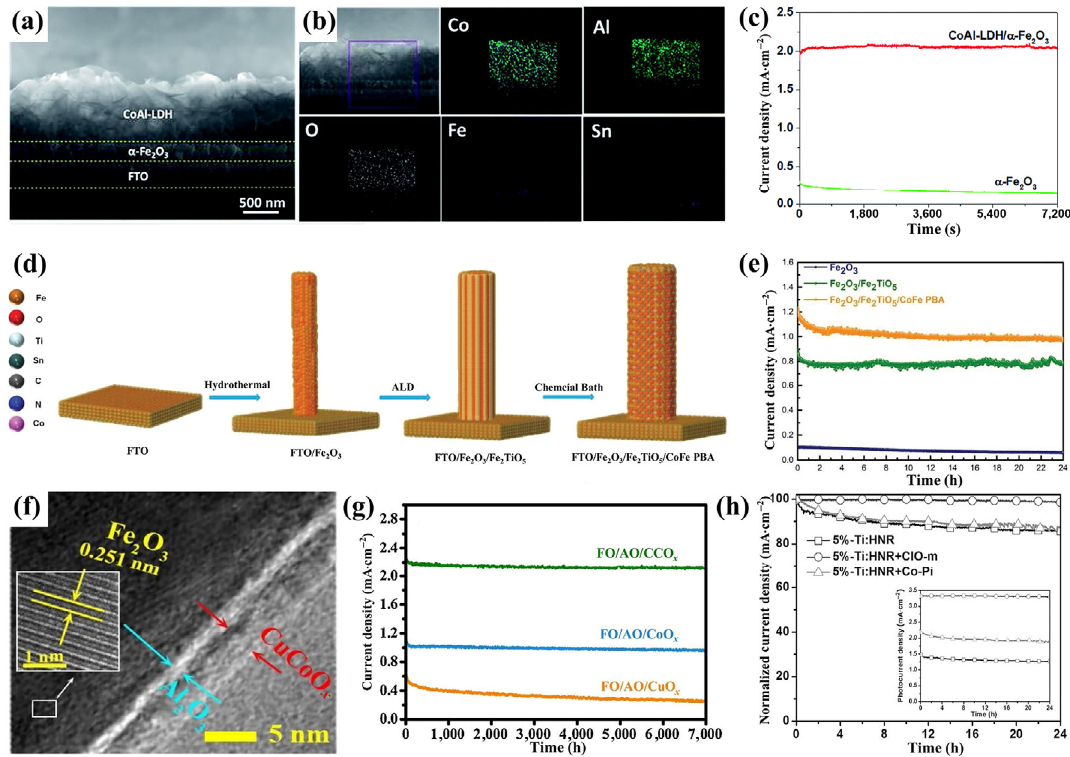
Figure 5 (a) Cross-sectional SEM image and (b) element mapping of CoAl-LDH/α-Fe 2 O 3 . (c) I – T curves of pristine Fe 2 O 3 and CoAl-LDH/Fe 2 O 3 in a 0.1 mol·L −1 Na-Pi buffer at 1.23 V vs. RHE. Reproduced with permission from Ref. [81], © The Royal Society of Chemistry 2017. (d) Schematic diagram of the synthesis of the Fe 2 O 3 /Fe 2 TiO 5 /CoFe PBA photoanode. (e) I – T curves at 1.23 V vs. RHE on Fe 2 O 3 , Fe 2 O 3 /Fe 2 TiO 5 , and Fe 2 O 3 /Fe 2 TiO 5 /CoFe-PBA photoanodes. Reproduced with permission from Ref. [78], © WILEY-VCH Verlag GmbH & Co. KGaA, Weinheim 2019. (f) High-resolution TEM (HRTEM) images of Fe 2 O 3 /Al 2 O 3 /CuCoO x NAs. (g) I – T curves at 1.23 V vs. RHE under AM 1.5G illumination. Reproduced with permission from Ref. [93], © Elsevier B.V. 2020. (h) I – T curves at 1.4 V vs. RHE for 24 h under constant AM 1.5G illumination, and the inset is the corresponding I – T pattern. Reproduced with permission from Ref. [96], © WILEY-VCH Verlag GmbH & Co. KGaA, Weinheim